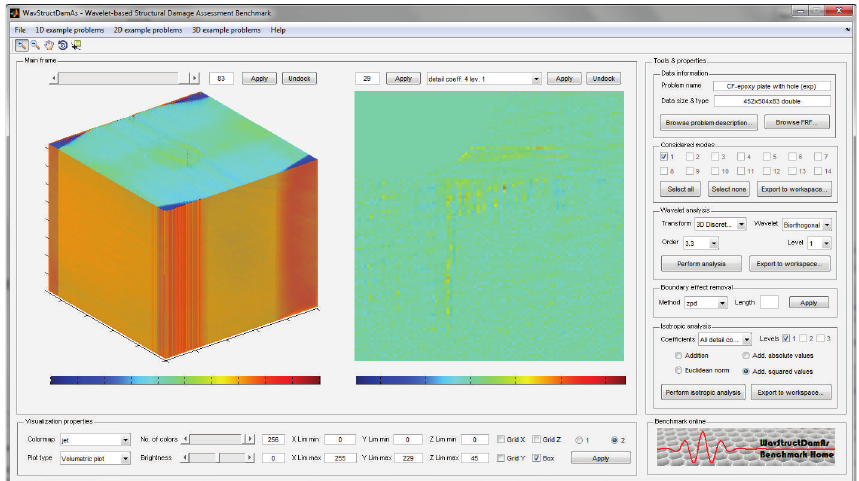
Figure 13: The benchmark results for SDI in CFRP plate with a hole and delaminations using 3D DWT-based